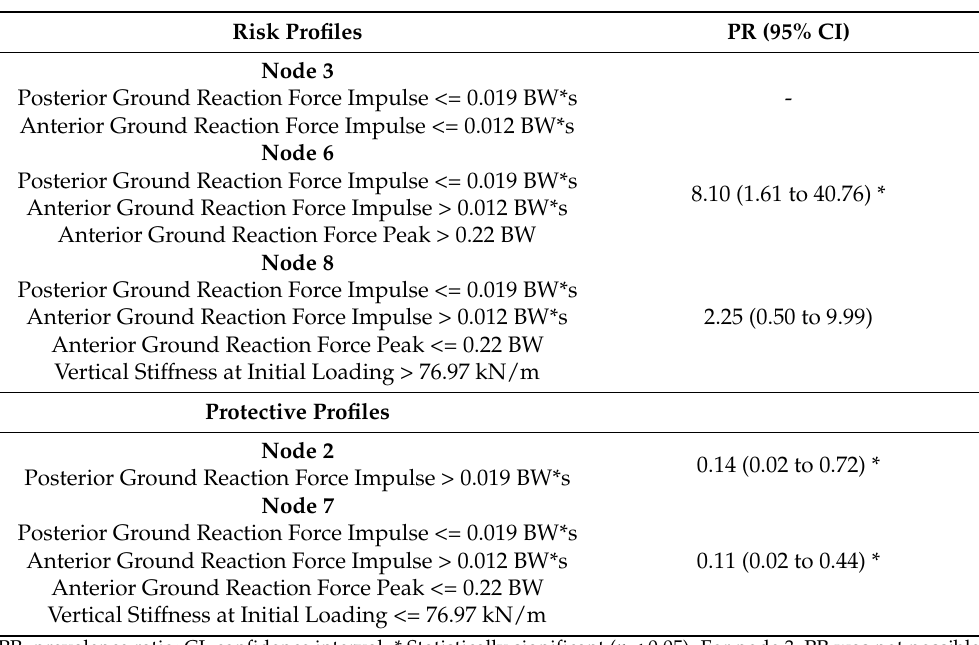
Figure 2. ROC curve for ITBS in runners. The area under the ROC curve was 0.87 ( p < 0.001). ROC, receiver operation characteristic. Table 3. Risk and protective profiles for ITBS (n =